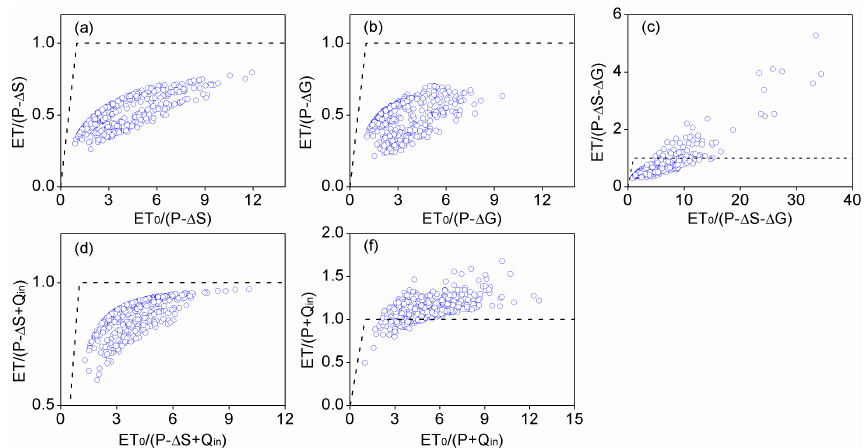
Figure 11. Five presentations of monthly water balance for region III considering different combinations in the water supply to evapotran-